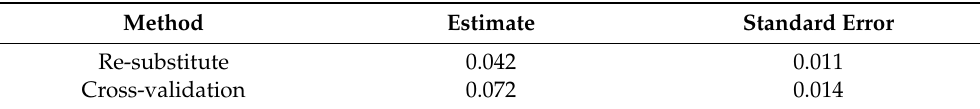
Table 11. Prediction accuracy values of QUEST-based lower limb motion comfort level analysis and determination